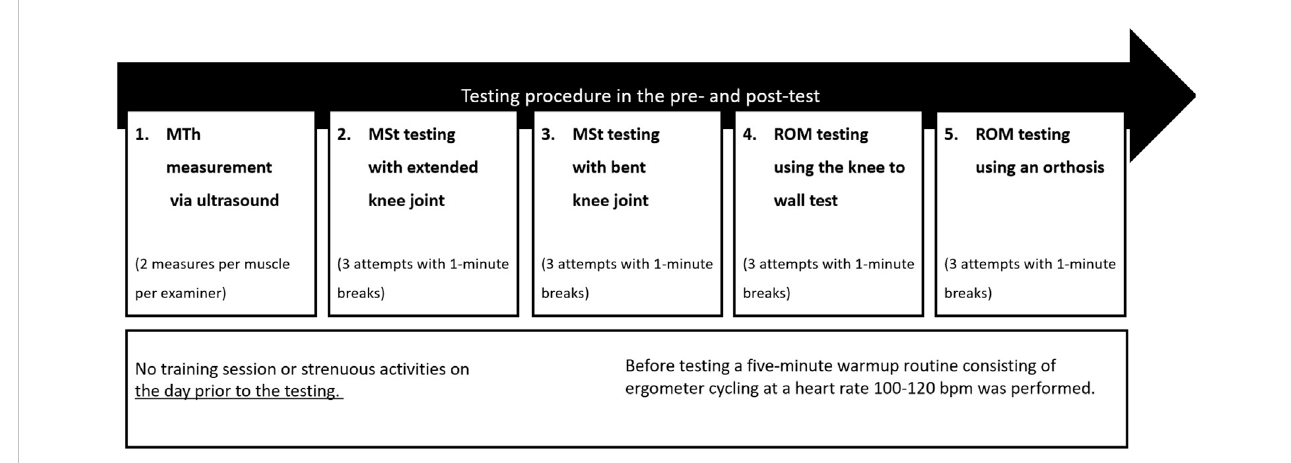
FIGURE 1 Graphical illustration of the testing procedure.